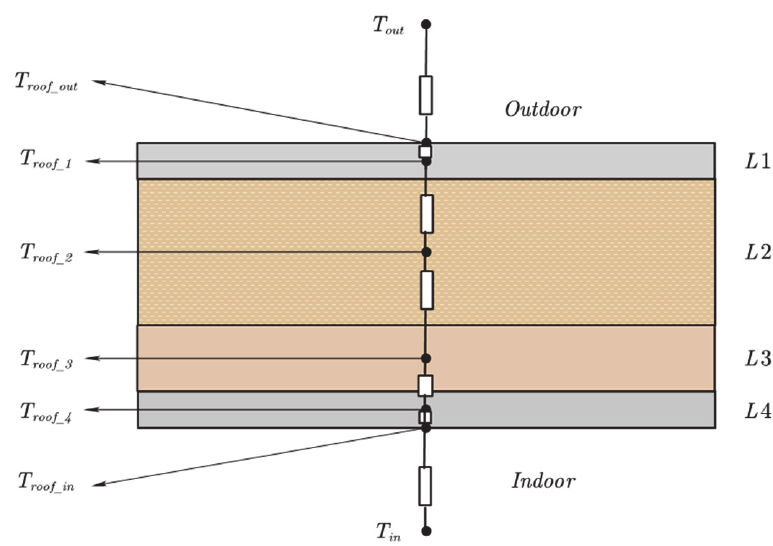
Figure 3. The nodes of roofs.